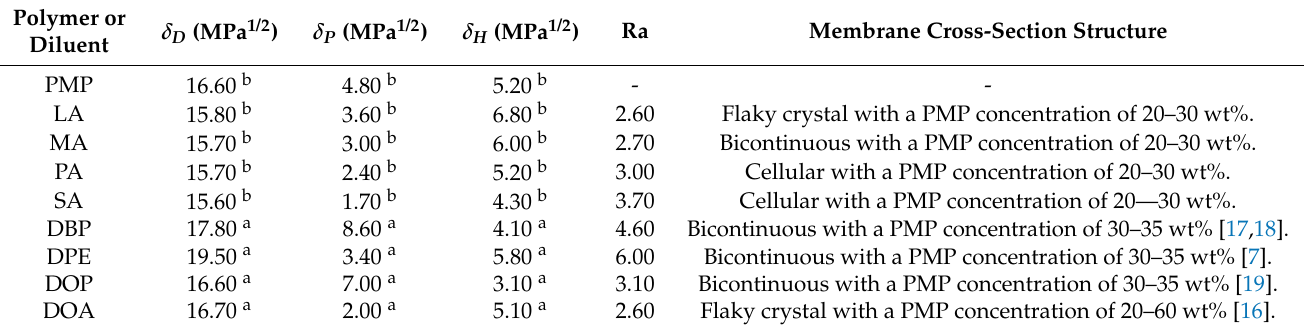
Membrane Cross-Section